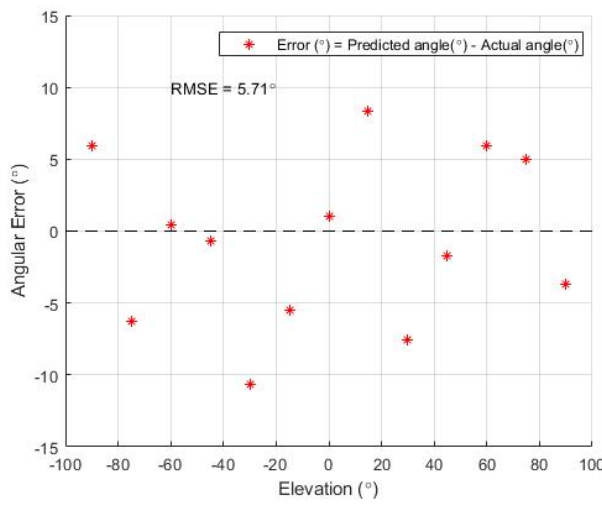
Figure 16. Estimation errors of elevation for different positions.